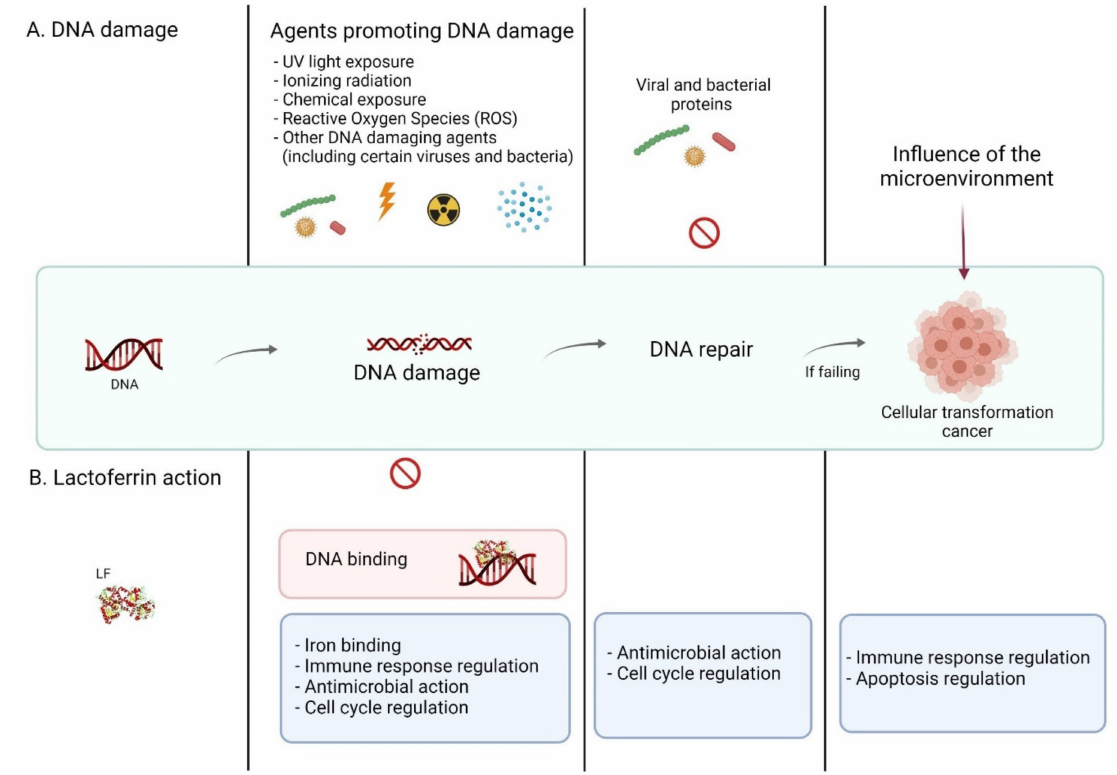
Figure 2. Major factors causing DNA damage and the protective effects of lactoferrin. Factors of external and internal origin as well as bacterial and viral infections can lead to mutations and permanent damage to human genetic material, causing premature aging and cell death, as well as severe impairment of the functions of tissues and organs, which in turn may lead to the development of various diseases, including cancer. In response to these carnivores, cells have developed defense mechanisms to prevent disease and repair damaged genetic material in the form of equal repair systems, such as BER or NER, or by diverting the cell to apoptosis. The protein supporting these mechanisms is Lactoferrin—an endogenous protein which, due to its unique structure, has numerous antibacterial, antiviral, antifungal and anticancer properties. These properties help to bind to damaged (modified) DNA, which supports the functioning of the mechanisms modulating the cell cycle at all its levels and the mechanisms of its repair. Illustration was created in BioRender.com (accessed on 21 April